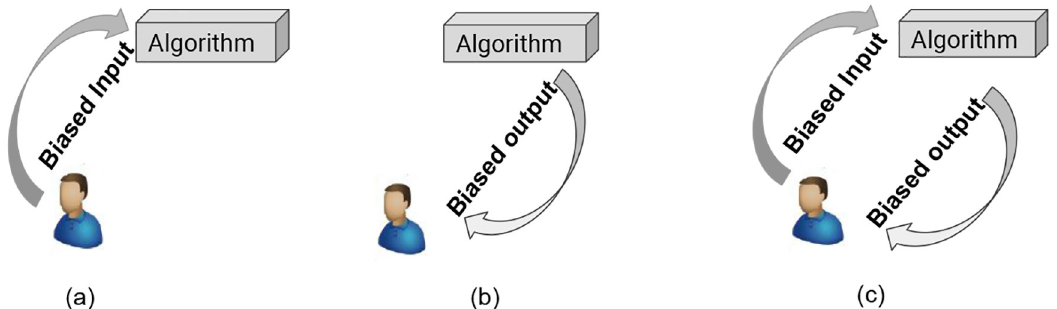
Fig 3. Evolution of bias between algorithm and human. In sub-figure (a), biased data from a human may lead to a biased algorithm, this is pre-algorithmic bias. In sub-figure (b), a biased algorithmic output might affect human behavior: For instance, by hiding certain items from humans, algorithms may affect human discovery, learning, and awareness in the long term. Sub-figure (c) indicates a continuous interaction between humans and algorithms that generates bias that we refer to as iterated bias , namely bias that results from repeated interaction between humans and algorithms